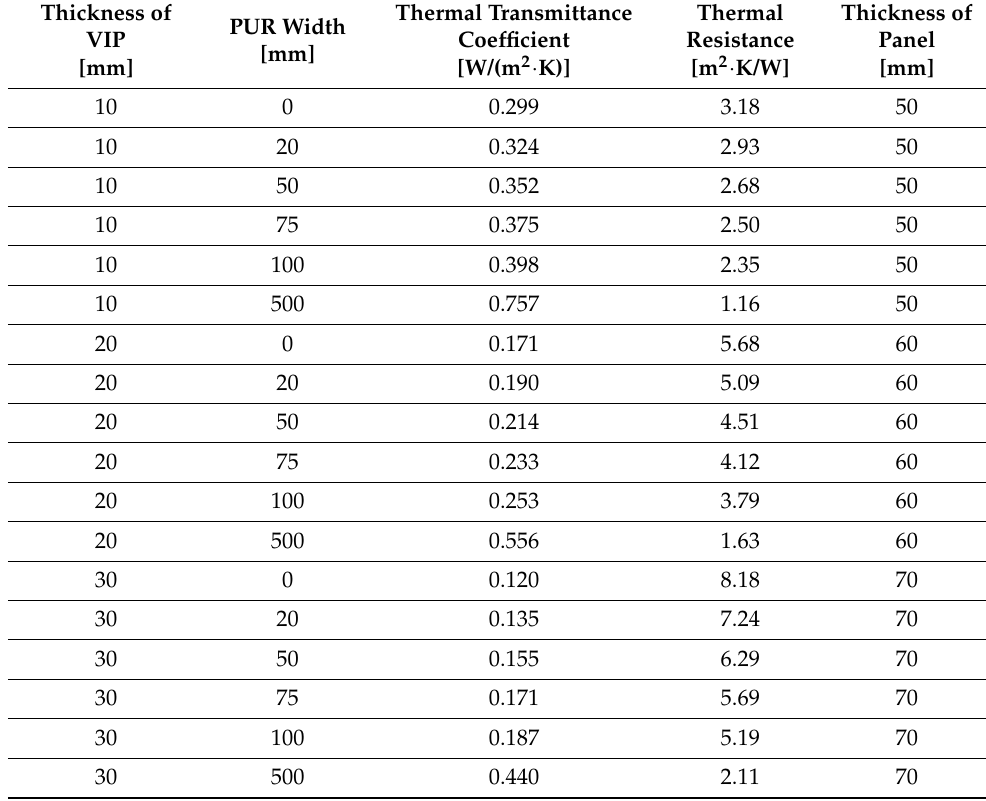
Table 2. Calculation results (main thermal insulation